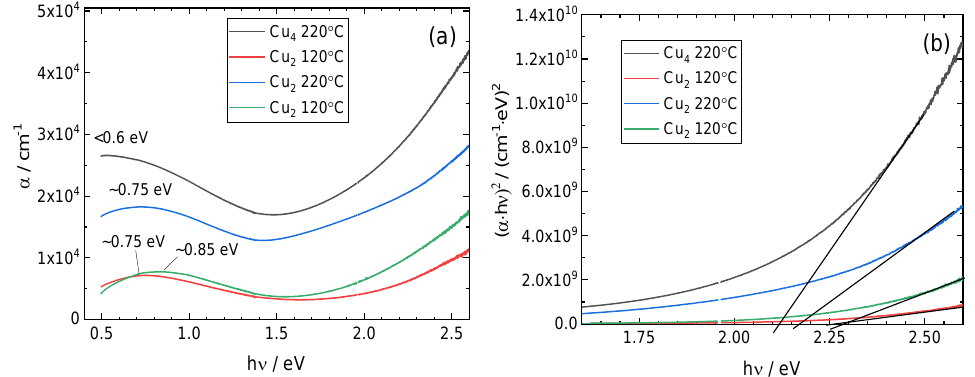
Figure 10. ( a ) Optical absorption in the near-infrared range exhibiting plasmon absorption by free charge carriers in the NCs. ( b ) Optical absorption in the visible, with the approximate position of the absorption edge indicated.